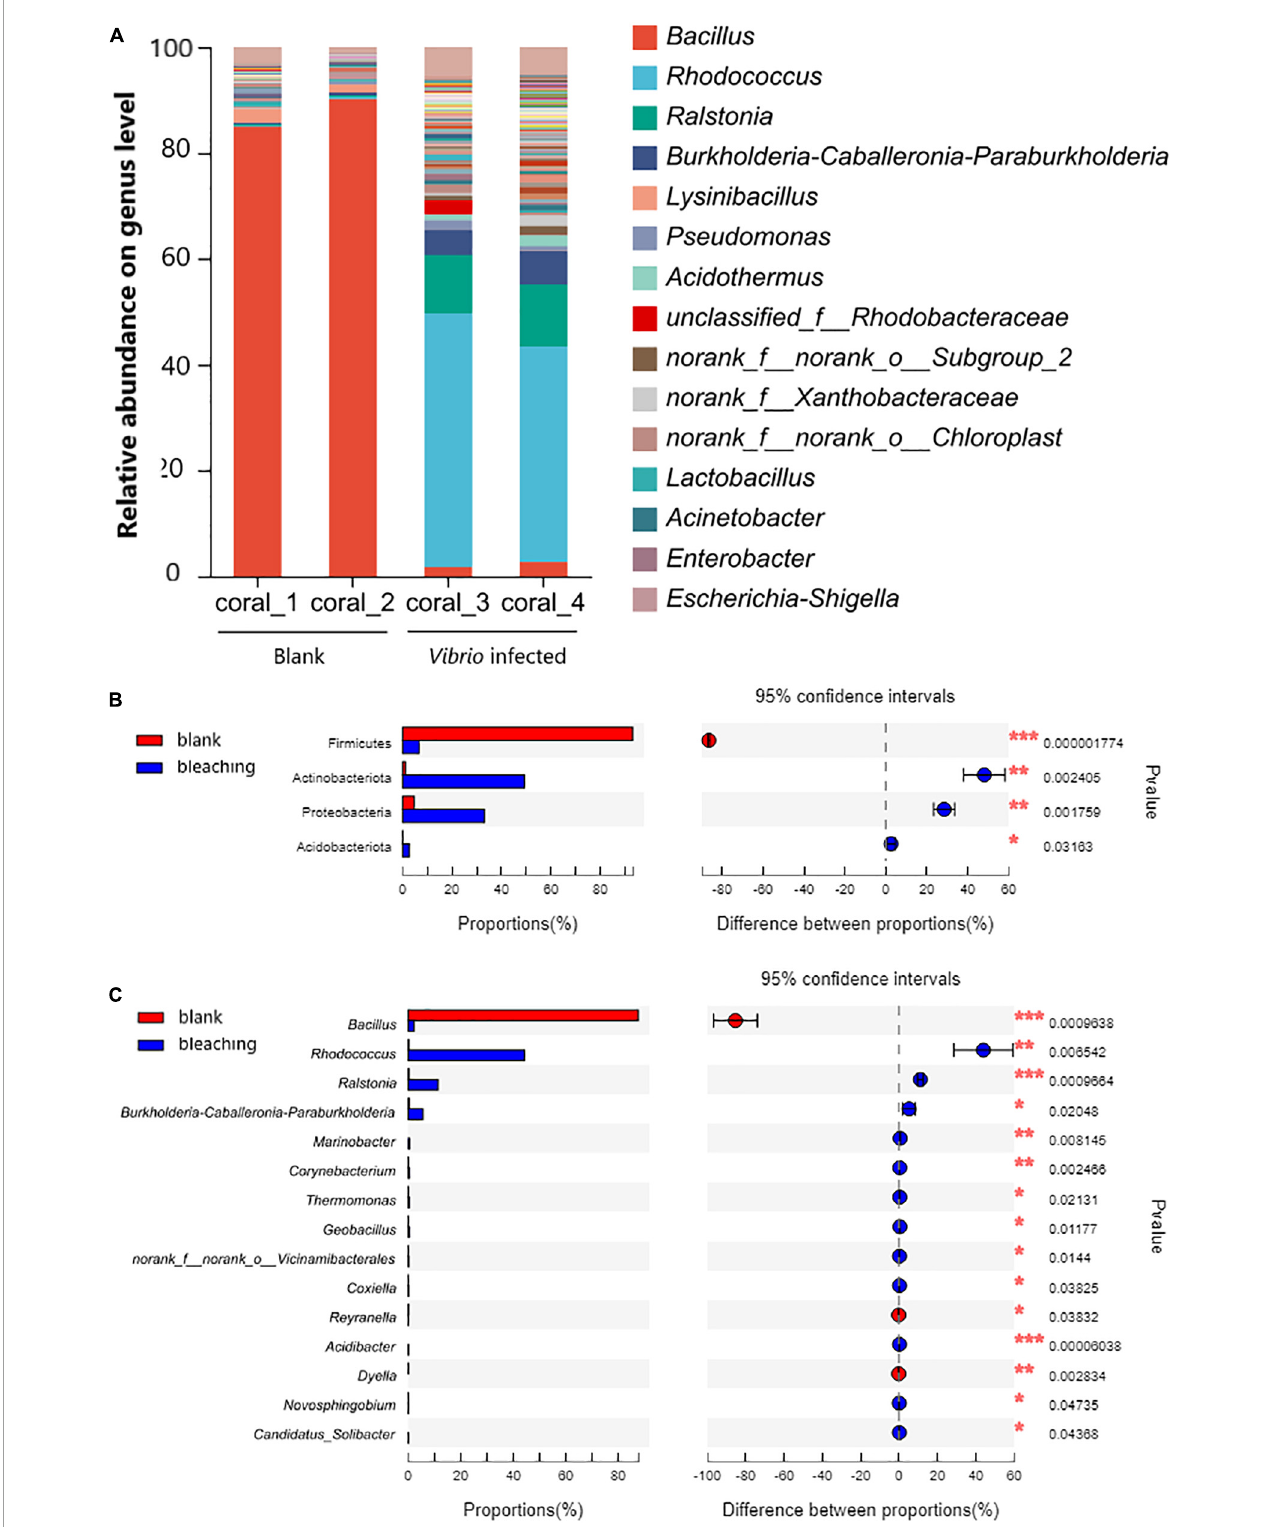
FIGURE6 Community composition of coral symbiotic bacteria on the genus level. The total genomic DNA of coral symbiotic microorganisms from each group performed high-throughput sequencing on the 16S rRNA. The taxonomy of each OTU representative sequence was analyzed by RDP classifier version 2.2 and classified on the genus level. The OTUs were analyzed by student’s t -test to compare the difference in abundance between groups: (A) is the microbial structure presented by relative community abundance; (B) is the phyla with a significant difference in abundance; and (C) is the top 15 genera with a significant difference in abundance were listed from higher abundance to low. Results of statistical analysis are presented by the significant difference indicated by * where 0.01 ≤ P ≤ 0.05, ** where 0.001 ≤ P ≤ 0.01, and *** where P ≤